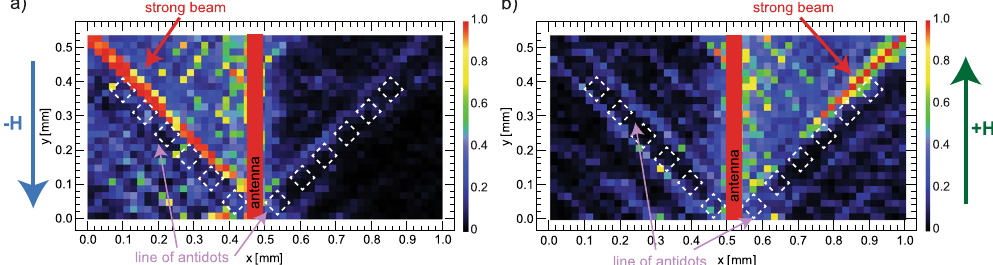
Figure 4. Experimental demonstration of the SWs beam switching property with the change of the magnetic field direction in the V-type geometry. ( a ) and ( b ) Two-dimensional BLS plots mapping the intensity of the SWs in switching between the beams propagating at + 45° and − 45° angle by change of the magnetic field direction from − H to + H